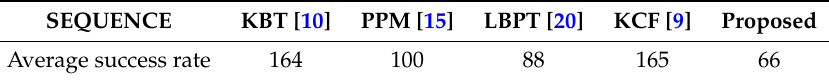
Table 6. Computation speed comparison